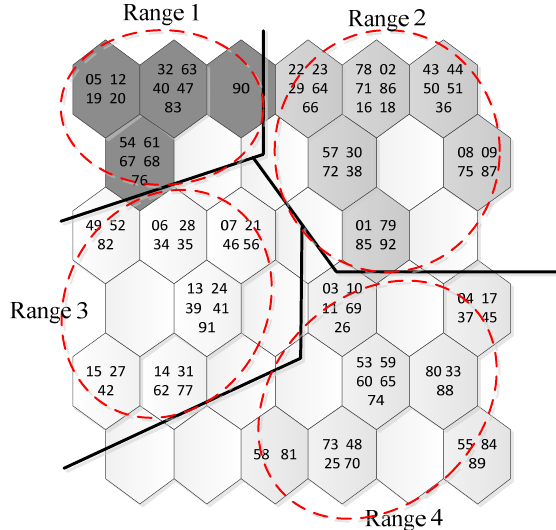
Figure 7. The clustering results of DSR in summer.